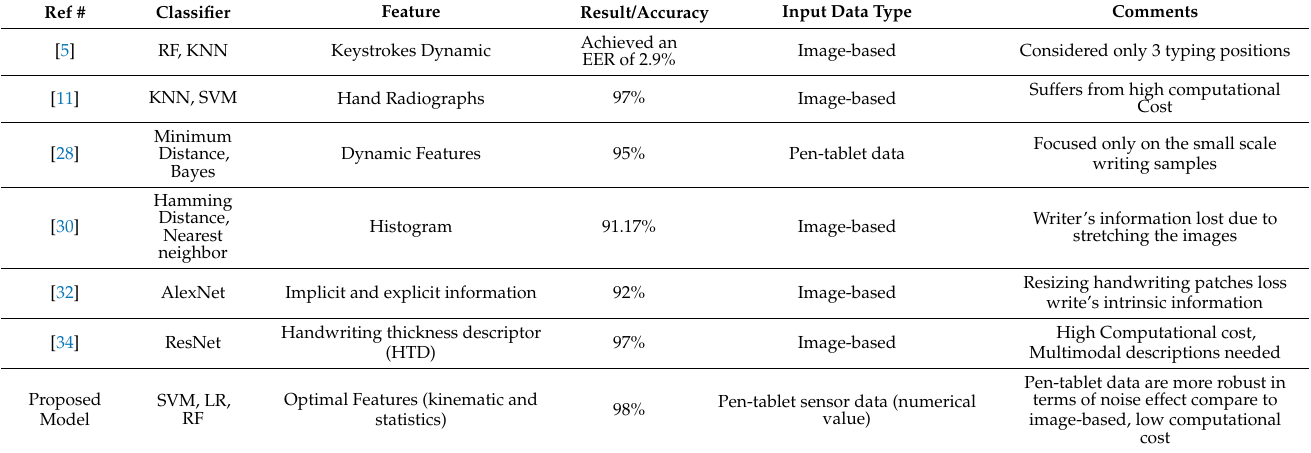
Figure 19. Class-wise accuracy (%) comparison of the proposed model with state-of-the-art image-based system. Table 8. Comparison of Proposed Scheme with State of